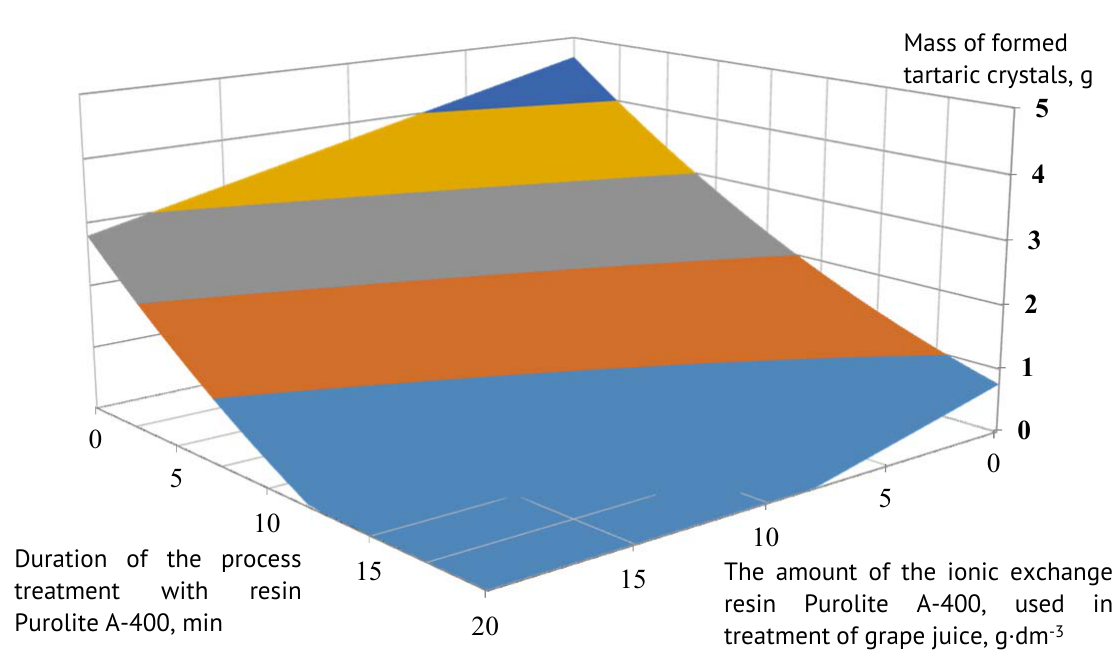
Figure 1. Graphical representation of the mathematical model of diminishing the formation of tartaric crystals in grape juice treated with ionic exchange